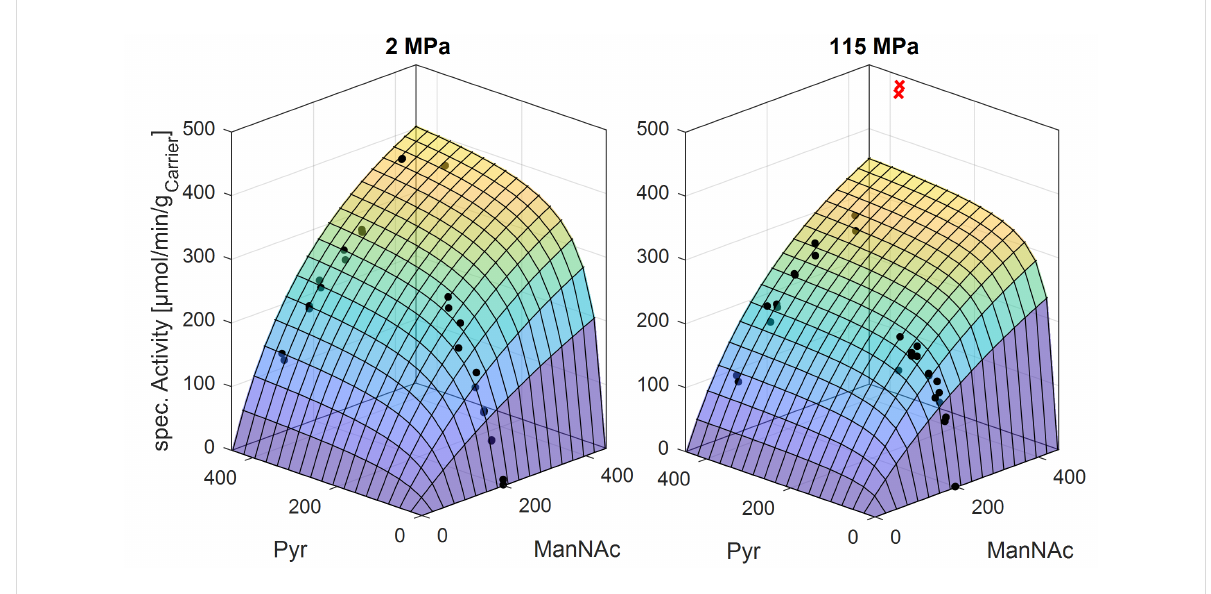
Figure 11: Measured kinetics of the aldolase when varying the pyruvate and ManNAc concentration (given in mM) at different pressures. Reaction conditions: 40 °C, flow rate: 1.5–2 mL/min, reactor volume: 0.70 mL, 100 mM potassium phosphate buffer (pH 7.50), 179.80 mg particles loaded with aldolase. Immobilisate was pestled.